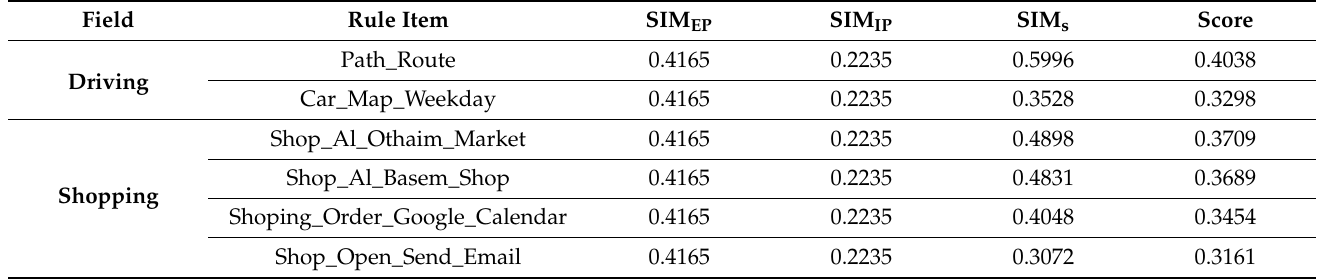
Table 3. List of recommended rules with second preferences configuration and context